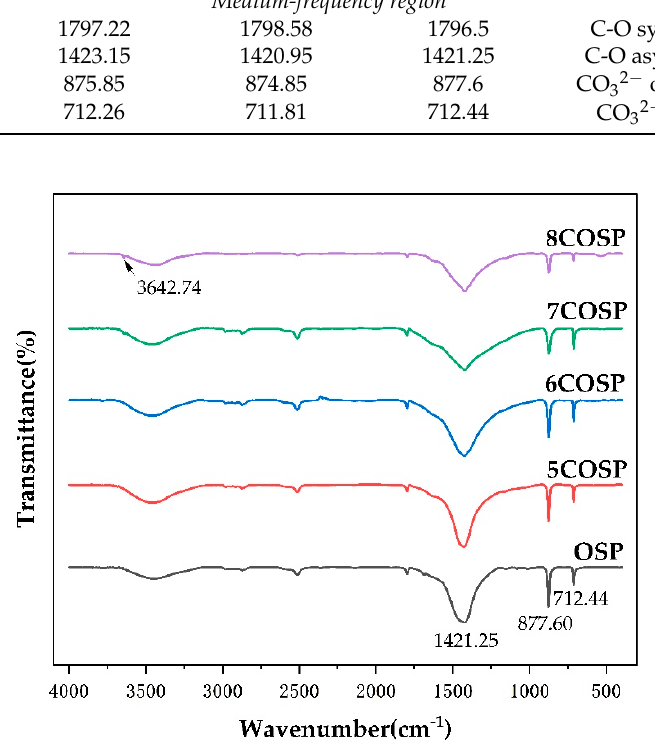
Figure 4. FTIR spectra of pre- and post-calcined OSP. Table 2. Infrared spectrum assignment of pre- and post-calcined OSP.